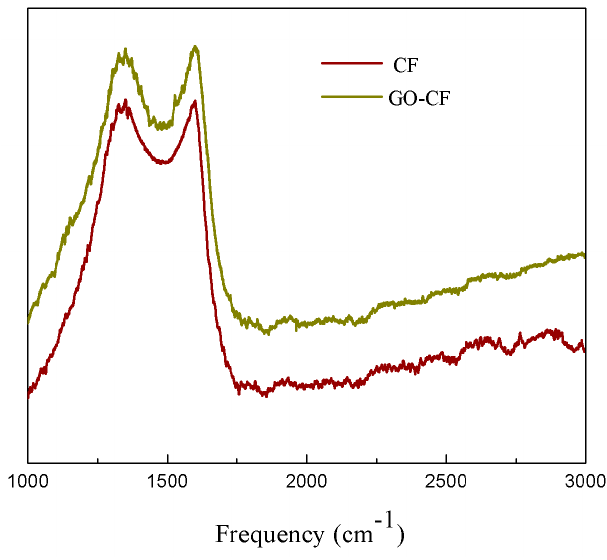
Figure 5. Raman spectra of CF before and after GO grafting.